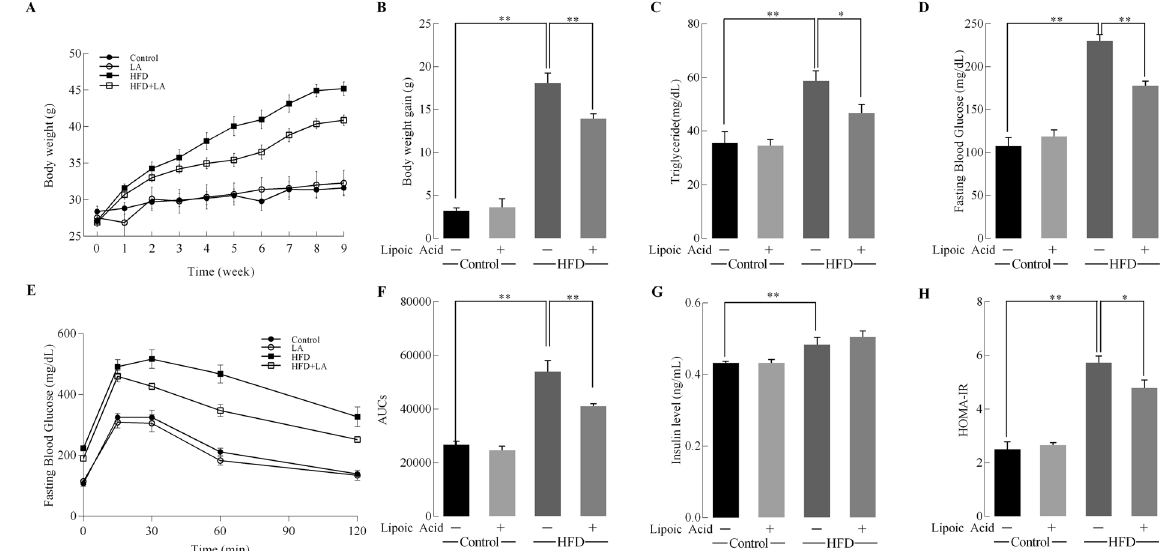
Figure 1. Effects of lipoic acid and HFD on body weight gain and insulin resistance. Mice were fed with 9-week HFD or normal diet, with or without lipoic acid administration in drinking water (0.23% w/v) and different parameters were monitored weekly or at the end of the 9-week period. ( A ) Body weight changes; ( B ) Body weight gain; At the end of the study (week 9) the following parameters were examined: ( C ) Plasma triglyceride levels; ( D ) Fasting glucose level; ( E ) Glucose tolerance test; ( F ) Area-under the curve values of glucose tolerance test; ( G ) Fasting insulin levels; ( H ) Insulin resistance index, HOMA-IR. Data presented as mean ± SD, n ≥ 5, * p < 0.05, ** p <